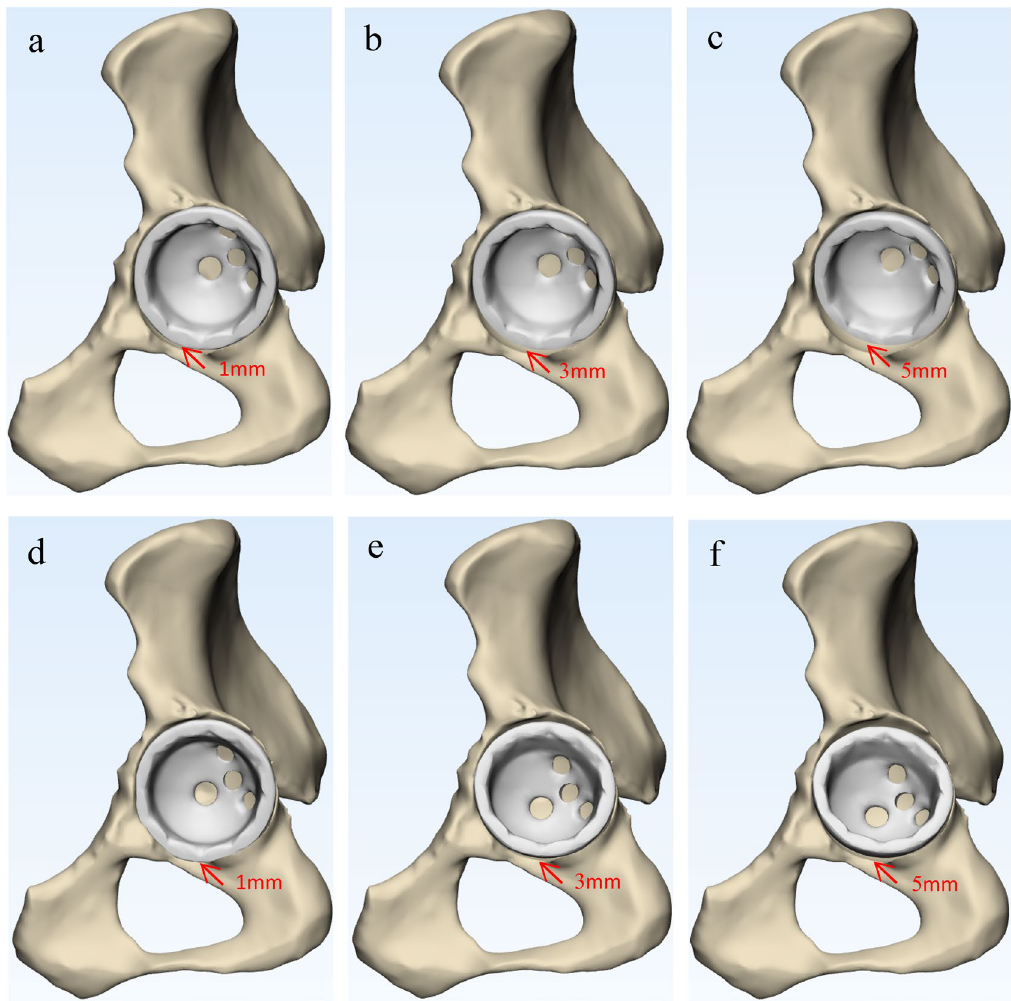
Figure 3. The position relationship between the inferior edge of acetabular cup and the proximal line of the anterior and posterior acetabular notches to determine cup inclination. ( a ) 1 mm proximal to the PLAPAN; ( b ) 3 mm proximal to the PLAPAN; ( c ) 5 mm proximal to the PLAPAN; ( d ) 1 mm distal to the PLAPAN; ( e ) 3 mm distal to the PLAPAN; ( f ) 5 mm distal to the